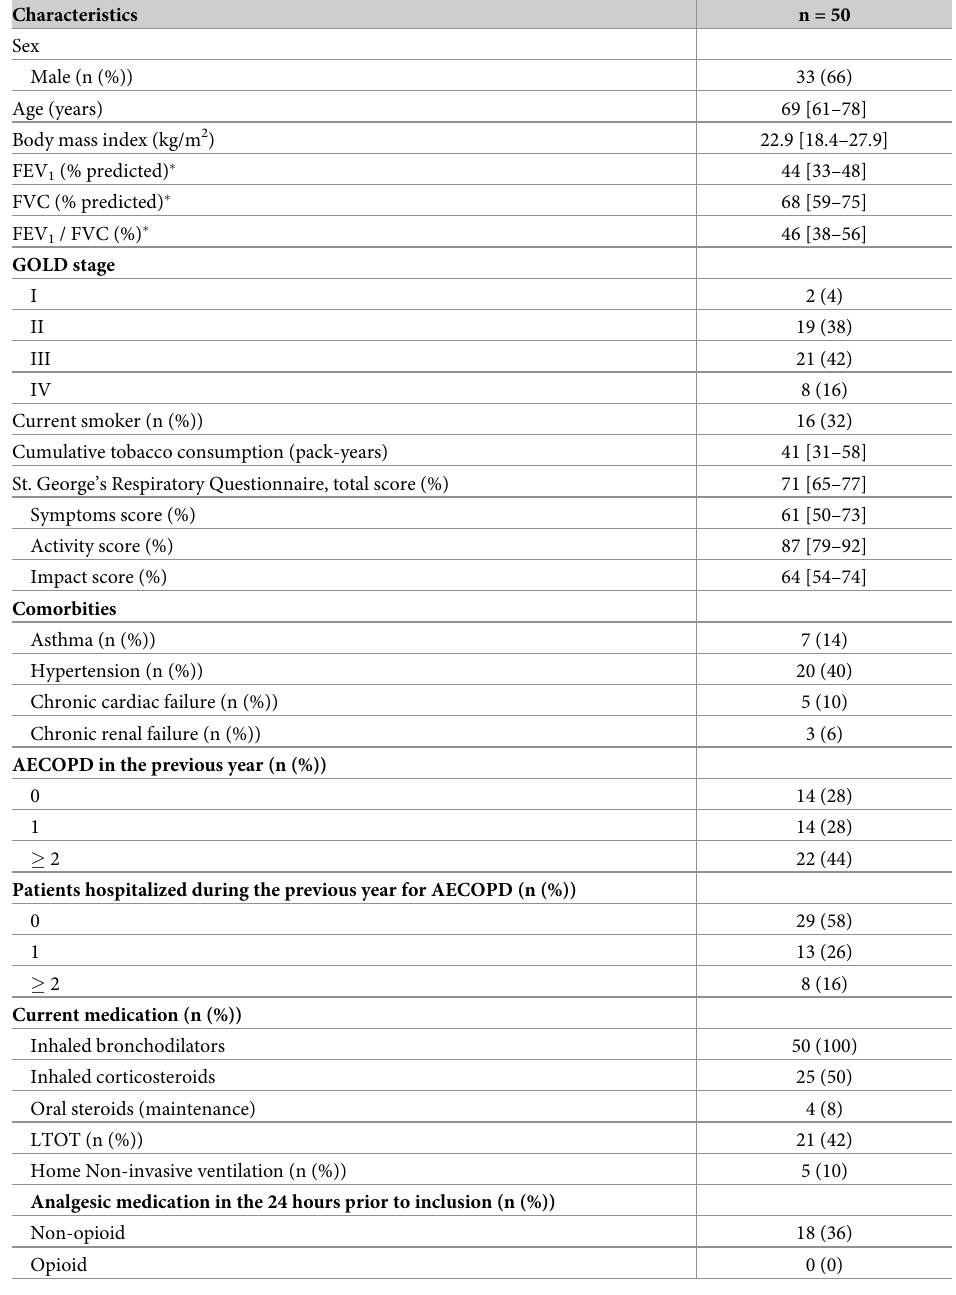
Table 1. Participant